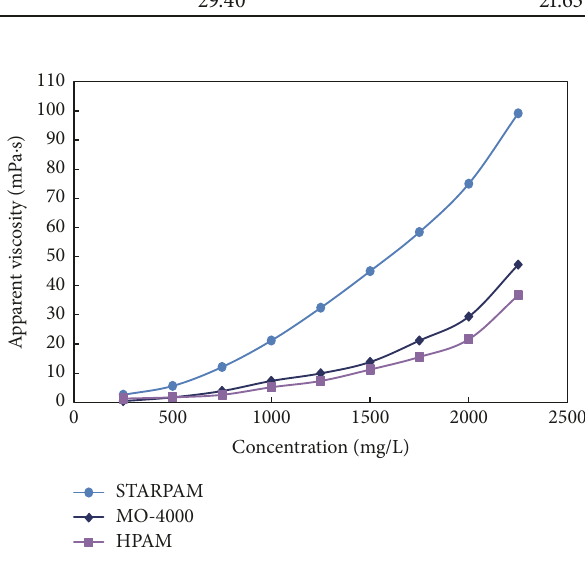
Figure 2: Comparison of adding